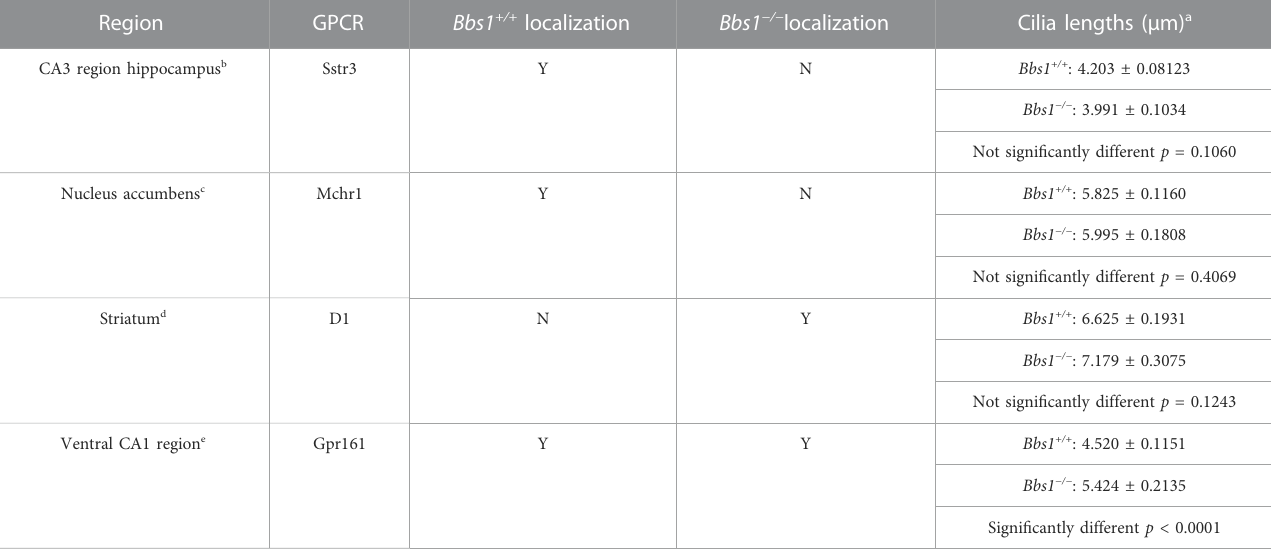
TABLE 1 Summary of GPCR ciliary localization and ciliary length in Bbs1 +/+ and Bbs1 − / − brain regions. Region